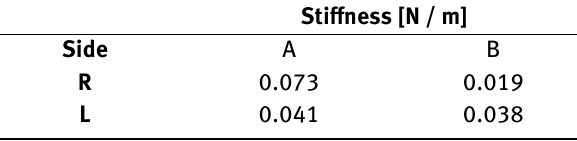
Table 2: Change of initial stiffness.